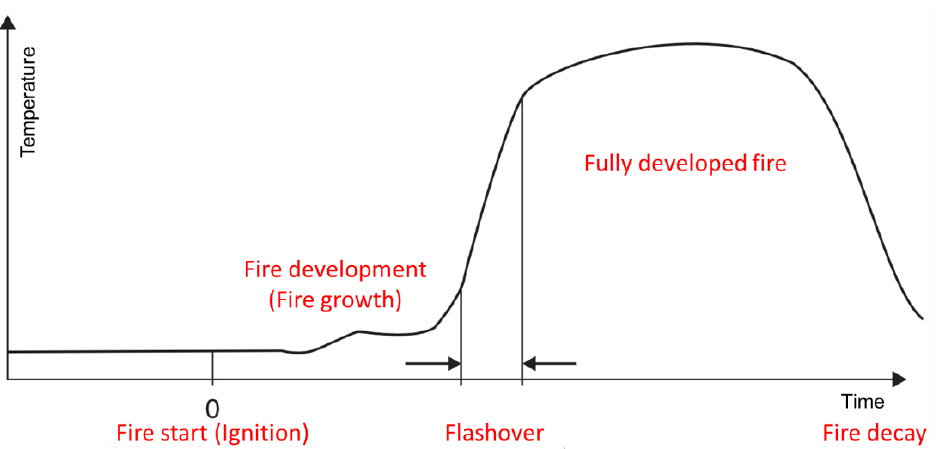
Figure 1. Schematic of a fire scenario. A typical fire scenario starts from ignition and fire growth, progresses to the fully developed fire, and finally reaches the fire decay stage. The fire starts and develops rapidly, and after a few minutes, it becomes severe. The generated vapor and heat initiate a flashover, which refers to the transition to total surface involvement in a fire of combustible materials. Reproduced with permission from Ref. [8]. Copyright 2011, Elsevier.